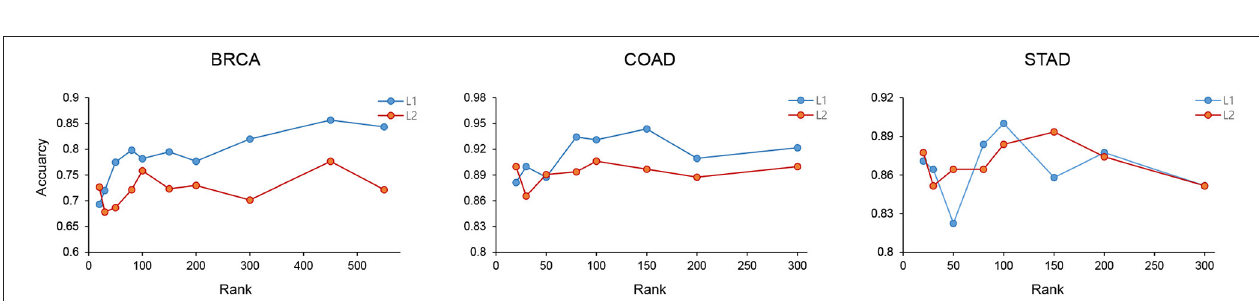
FIGURE 4 | An illustration of the non-negative tensor decomposition (PARAFAC) using three types of omics. The tensor T is decomposed into three components: gene, sample (patient), and omics. Each component corresponds to one axis in tensor T . Each component is a two-dimensional matrix where one axis embeds the rank features f i ( i = 0,..., r ) for the entities in each component (i.e., genes, samples, and omics), similar to the traditional matrix factorization method.